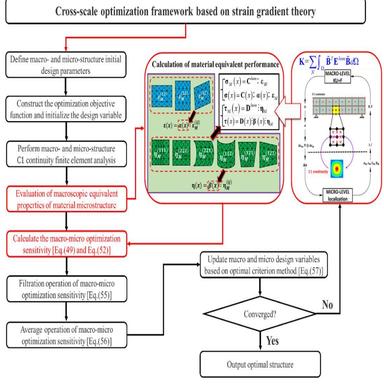
Framework of the cross-scale optimization.